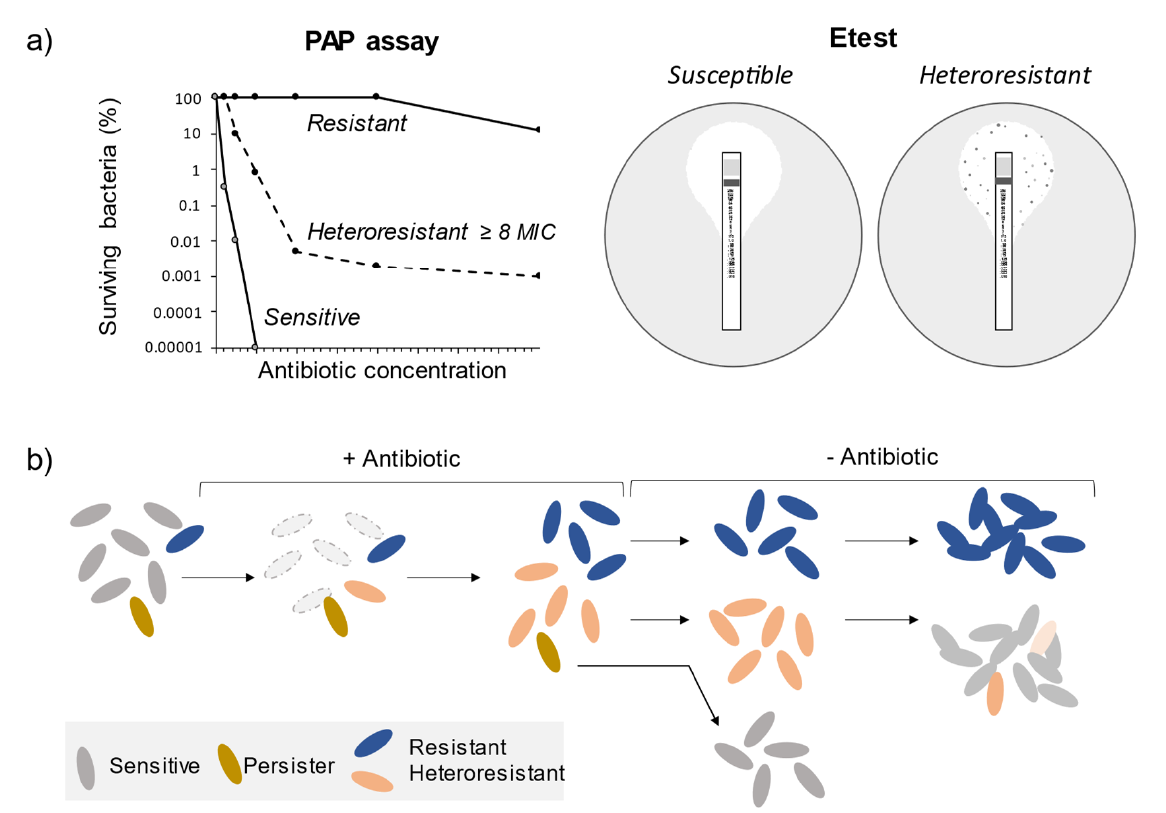
Figure 1. Heteroresistance detection methods and the difference between persister, resistant, and heteroresistant bacteria. ( a ) In the PAP assay, bacteria are spread on agar plates with increasing concentrations of antibiotics. Heteroresistance is determined as the growth of colonies at ≥ 8 × MIC of the main cell population. In the Etest assay, heteroresistance is determined by visible growth of colonies within the zone of clearing around the strips with a preformed continuous gradient of antibiotic concentrations. ( b ) Resistant bacteria that emerge before or during antibiotic treatment can grow in the presence of the antibiotic. They give rise to new populations distinct from the original ones. In the case of heteroresistance, resistant cells revert to the susceptible phenotype after the antibiotic treatment, usually due to high fitness costs. Persister cells can survive antibiotic treatment, but they cannot grow in the presence of the antibiotic. After the treatment, persisters can resume growth, switching back to the sensitive phenotype.